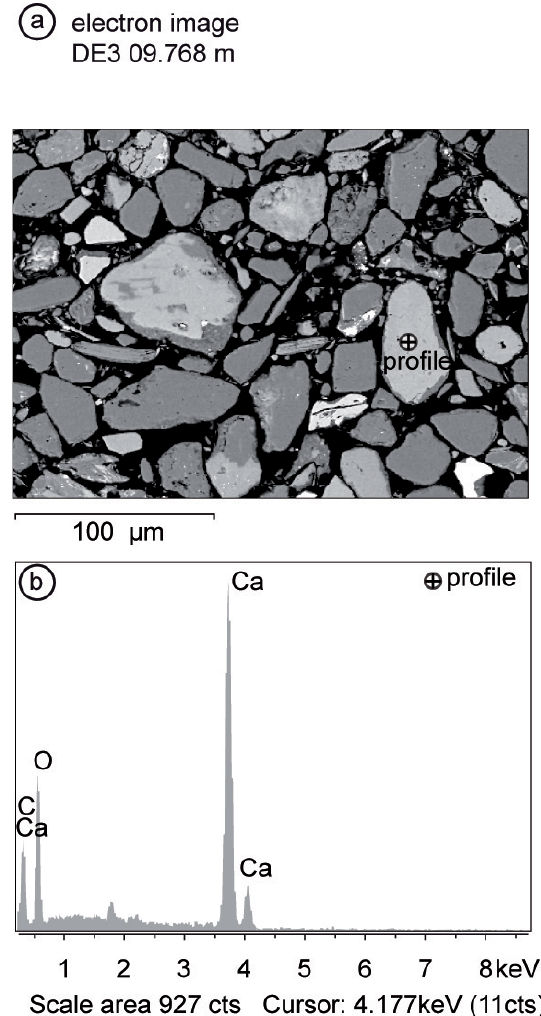
Fig. 4. (a) The electron image of a sample sequence of core DE3 (depth: 9.768m) shows the particle composition of an east wind layer. The sediment consists of well sorted quartz grains, carbon- ates and lithic components. The marked point in the center of a grain represents the geochemical profile shown in plot b. (b) The geochemical analysis (Zeiss DSM 962) of a large particle (a) shows a spectrum with pronounced carbonate bands. The ECD (equivalent circle diameter) of about (55µm is equal to the main part of particles in the sample sequence and typical for loess-like eolian